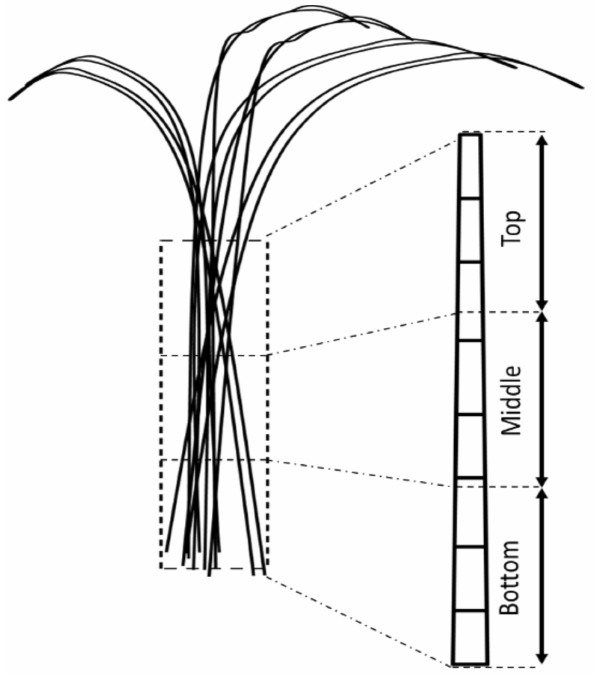
Figure 2. Bamboo culm parts (bottom, middle, and top) for analysis of chemical components and physical–mechanical properties of